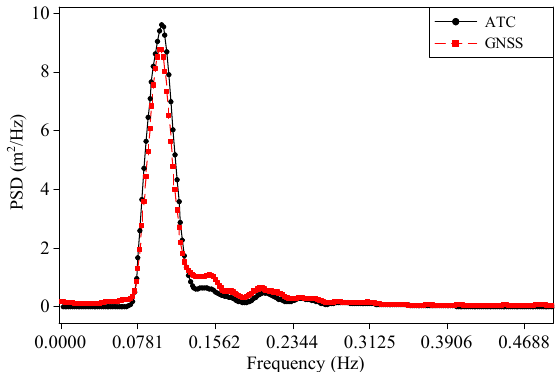
Figure 8. PSD obtained from the ATC sensor and GNSS receiver at 09:00 on 21 August 2013.